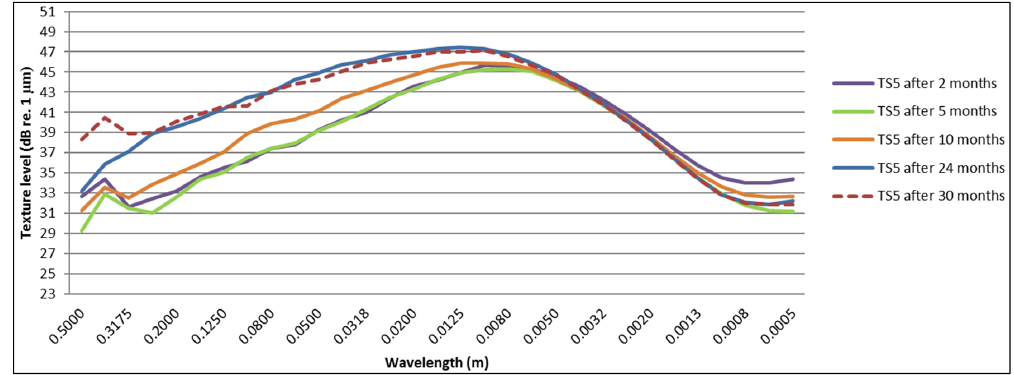
Figure 17. Change in texture spectra over a period of 30 months for Test Section 2.